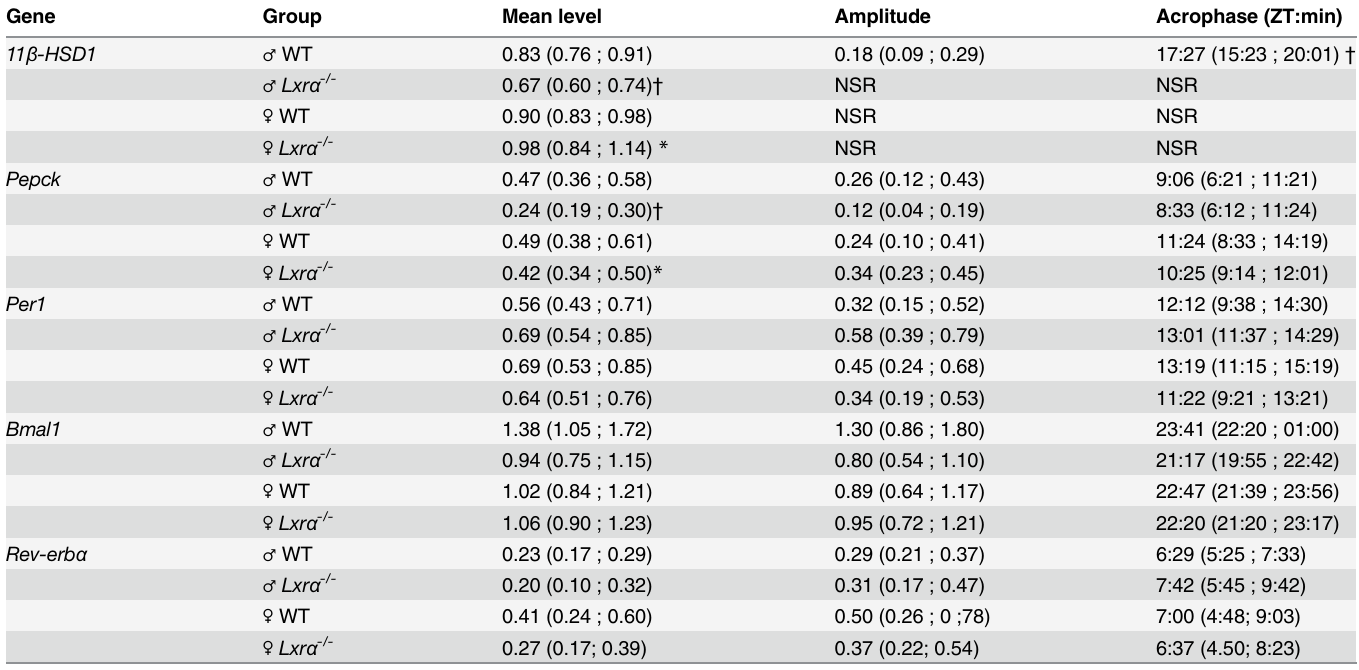
For each parameter measured, values are represented as median ± 95% bootstrap con fi dence intervals. * indicates signi fi cant differences between females vs males † indicates signi fi cant differences between Lxr α -/- vs WT